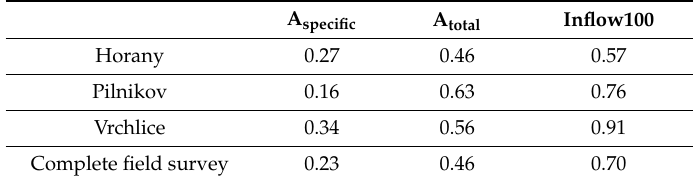
Table 1. Correlation (correlation coefficient) between tested model outputs value and threat category determined within field survey.